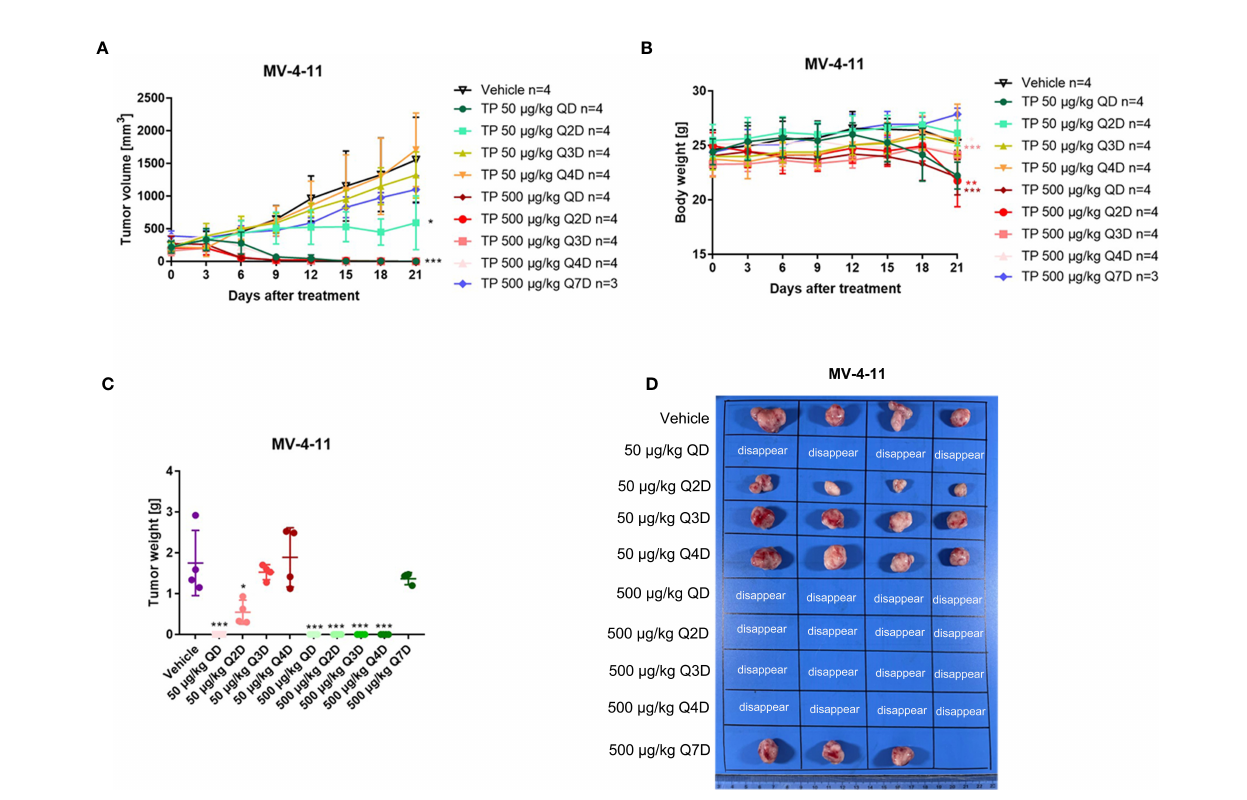
FIGURE 7 | The change of the administration model for triptolide in MV-4-11 xenograft has similar anti-AML activity at the same dosage. 5×10 6 MV-4-11 cells were injected into BALB/C nude mice subcutaneously. When the tumor volume reached 200 mm 3 , mice were randomly assigned to ten treatment groups and treated with triptolide at a dose of 50 m g/kg or 500 m g/kg daily (QD) or every other day (Q2D), every two days (Q3D), and every three days (Q4D) via an intraperitoneal injection for 21 consecutive days. Tumor volume (A) and bodyweight (B) was measured every two days. At the end of the study, tumors were weighed (C) and photographed (D) . * p < 0.05; ** p < 0.01; *** p <